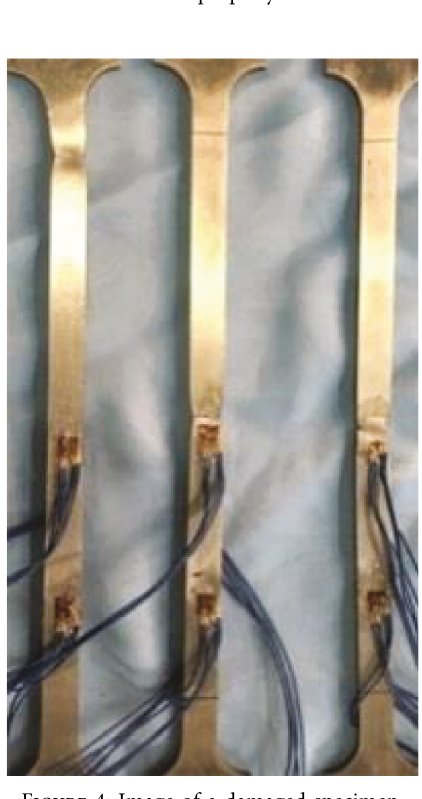
Figure 3: Mechanical property test of materials.